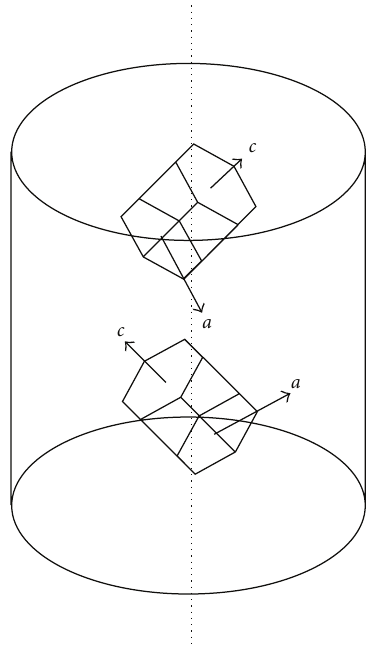
Figure 3: Schematic diagram showing textures of monolithic AZ91/ZK60A and AZ91/ZK60A/AlN nanocomposite based on goniometer X-ray di ff raction. In each case, vertical axis (dotted line) is parallel to extrusion direction. Each cell is made up of 2 HCP units having 1 common (0 0 0 2) basal